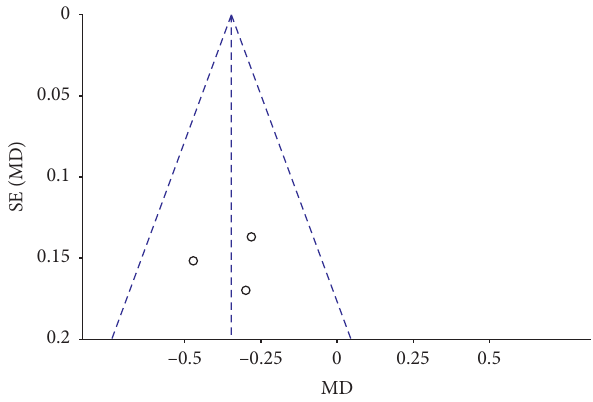
Figure 12: A funnel plot of postoperative BCVA at 12 months after surgery showing no significant publication bias. BCVA � best- corrected visual acuity, SE � standard error, MD � mean